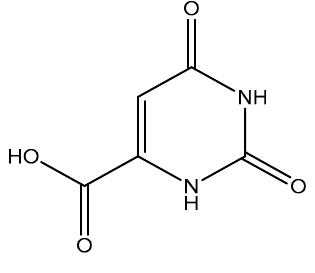
Figure 3. Structure of orotic acid.